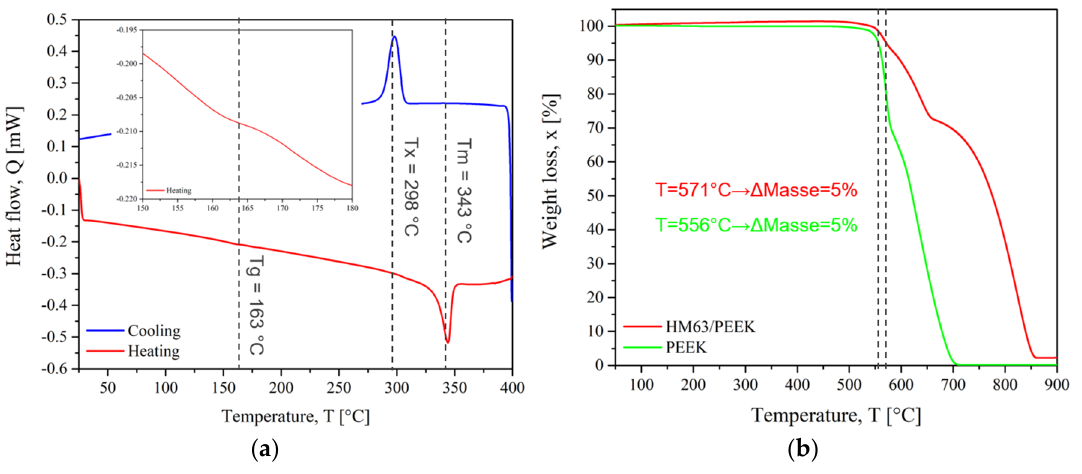
Figure 8. CF/PEEK thermograms ( a ) DSC and ( b ) TGA.